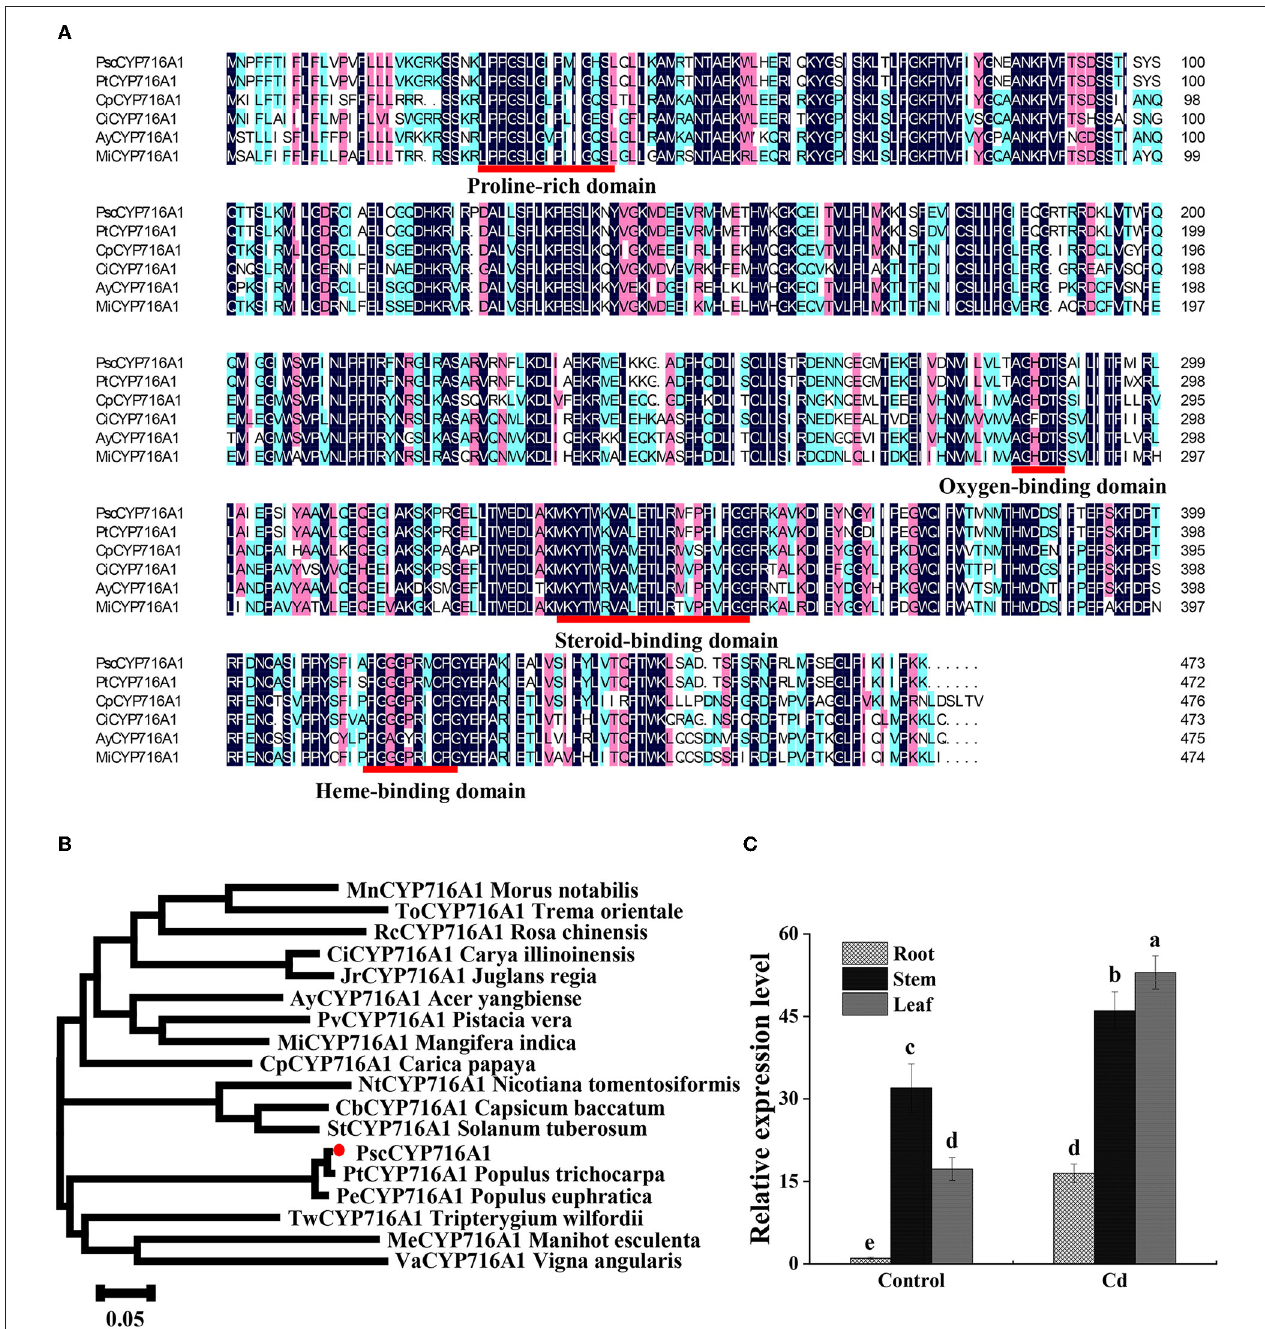
FIGURE 1 | Expression and evolutionary analysis of PscCYP716A1 gene. (A) Multiple sequence alignment: proline-rich, oxygen-binding, heme-binding domain, and steroid-binding domains are underlined in red. The shaded regions shown in black, pink, and light green indicate amino acid sequences similarity rate reached 100, 75, and 50%, respectively. (B) Phylogenetic tree. GenBank accession numbers of these genes are as follows: PtCYP716A1 (XP_024442884.1) from Populus trichocarpa , PeCYP716A1 (XP_011040241.1) from Populus euphratica , MeCYP716A1 (KAG8637047.1) from Manihot esculenta , CiCYP716A1 (KAG2682220.1) from Carya illinoinensis , CbCYP716A1 (PHT43919.1) from Capsicum baccatum , JrCYP716A1 (XP_018811315.1) from Juglans regia , AyCYP716A1 (TXG67812.1) from Acer yangbiense , StCYP716A1 (KAH0744930.1) from Solanum tuberosum , TwCYP716A1 (XP_038685630.1) from Tripterygium wilfordii , MiCYP716A1 (XP_044473624.1) Mangifera indica , ToCYP716A1 (POO00380.1) from Trema orientale , VaCYP716A1 (KOM46504.1) from Vigna angularis , CpCYP716A1 (XP_021892940.1) from Carica papaya , RcCYP716A1 (XP_024160401.1) from Rosa chinensis , PvCYP716A1 (XP_031249446.1) from Pistacia vera , NtCYP716A1 (XP_009607400.1) from Nicotiana tomentosiformis , MnCYP716A1 (XP_024018624.1) from Morus notabilis . The scale bar represents 0.05 amino acid substitutions per site. (C) RT-qPCR analysis of PscCYP716A1 in response to 50 µ M CdCl 2 treatment for 6h. The expression level of root in control was set to 1. All data were shown as mean ± SD of three biological duplicates. Different letters indicate that the mean values are significantly different between the transgenic poplars and WT ( p < 0.05).